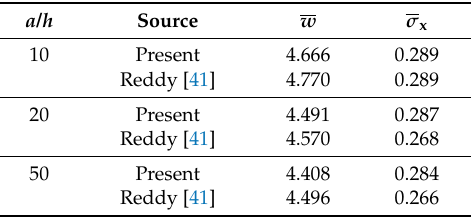
Table 3. Comparison of non-dimensional maximum deflection and normal stress of square isotropic plate subjected to uniform load.